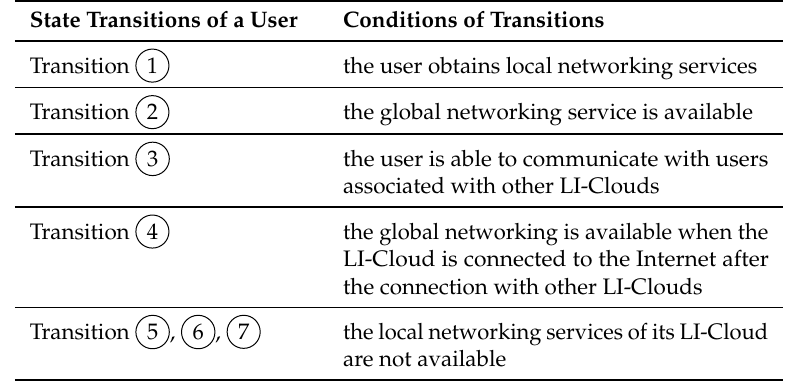
Table 3. State transition conditions of a user.